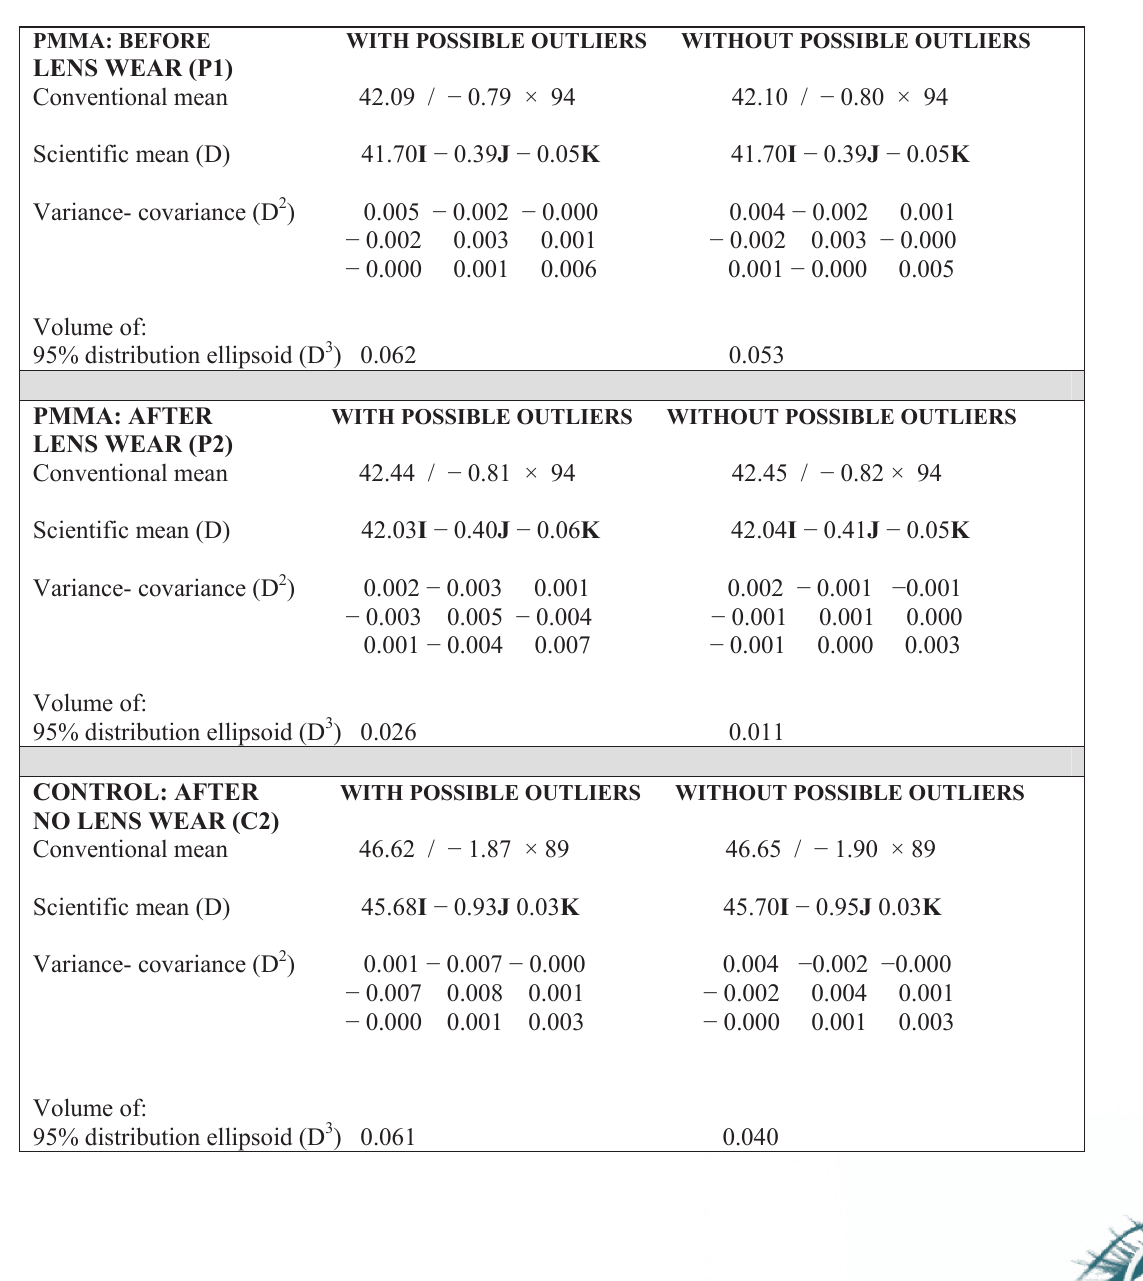
Figure 6 . Stereo-pair scatter plot (with included 95% distribution ellipsoids) of C1 (black data points) and C2 (red data points) devoid of possible outliers. The origin of the scatter plot is 45.65 I D. Table 2 . Statistics (means, variance-covariance matrices and ellipsoid volumes) for samples P1, P2 and C2 with and without pos - sible